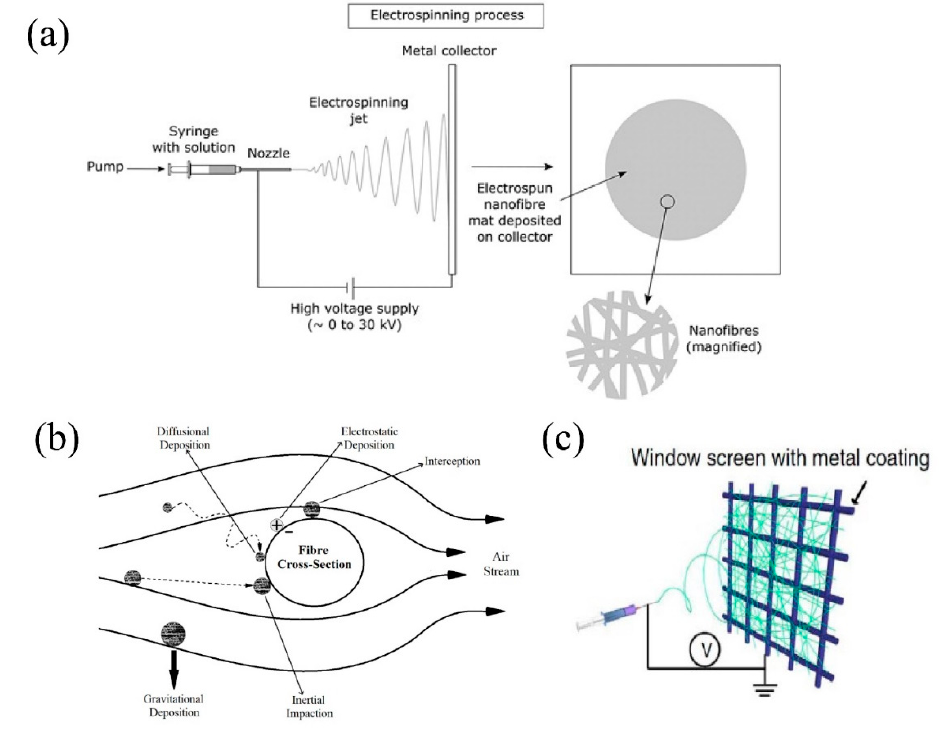
Figure 1. ( a ) Schematic diagram of processing steps for the fabrication of nanofibers. Reprinted with permission from ref. [15]. Copyright 2017 Taylor & Francis. ( b ) Main filtration mechanism of air filter. Adapted with permission from ref. [6]. Copyright 2020 Elsevier B.V. ( c ) Schematics showing the fabrication of transparent air filter by electrospinning. Adapted with permission from ref.